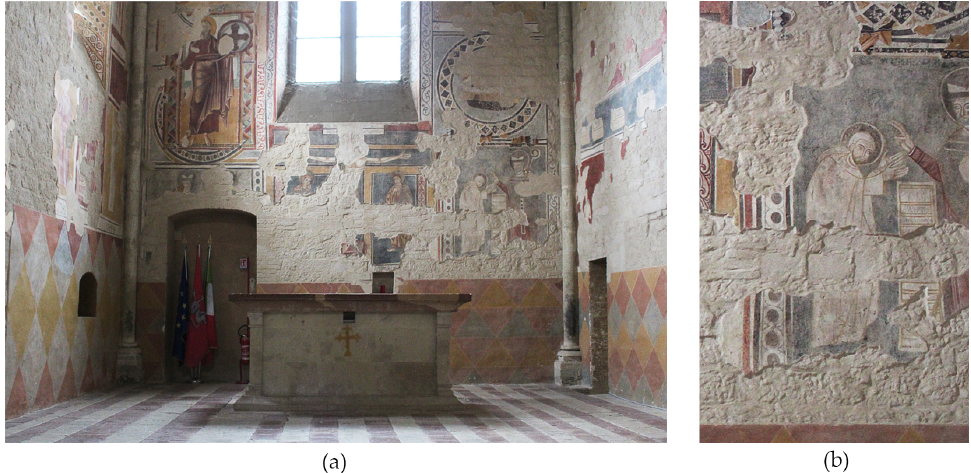
Figure 4. ( a ) Pictures of the altar, in background the lower register of the apse’frescoes. ( b ) Detail of the friar Bevignate depicted with a halo as if he were already a Saint and with the white habit consistently with the Templars observable in the counter-façade’s mural paintings (see cones of vision 2 and 3 in Figure